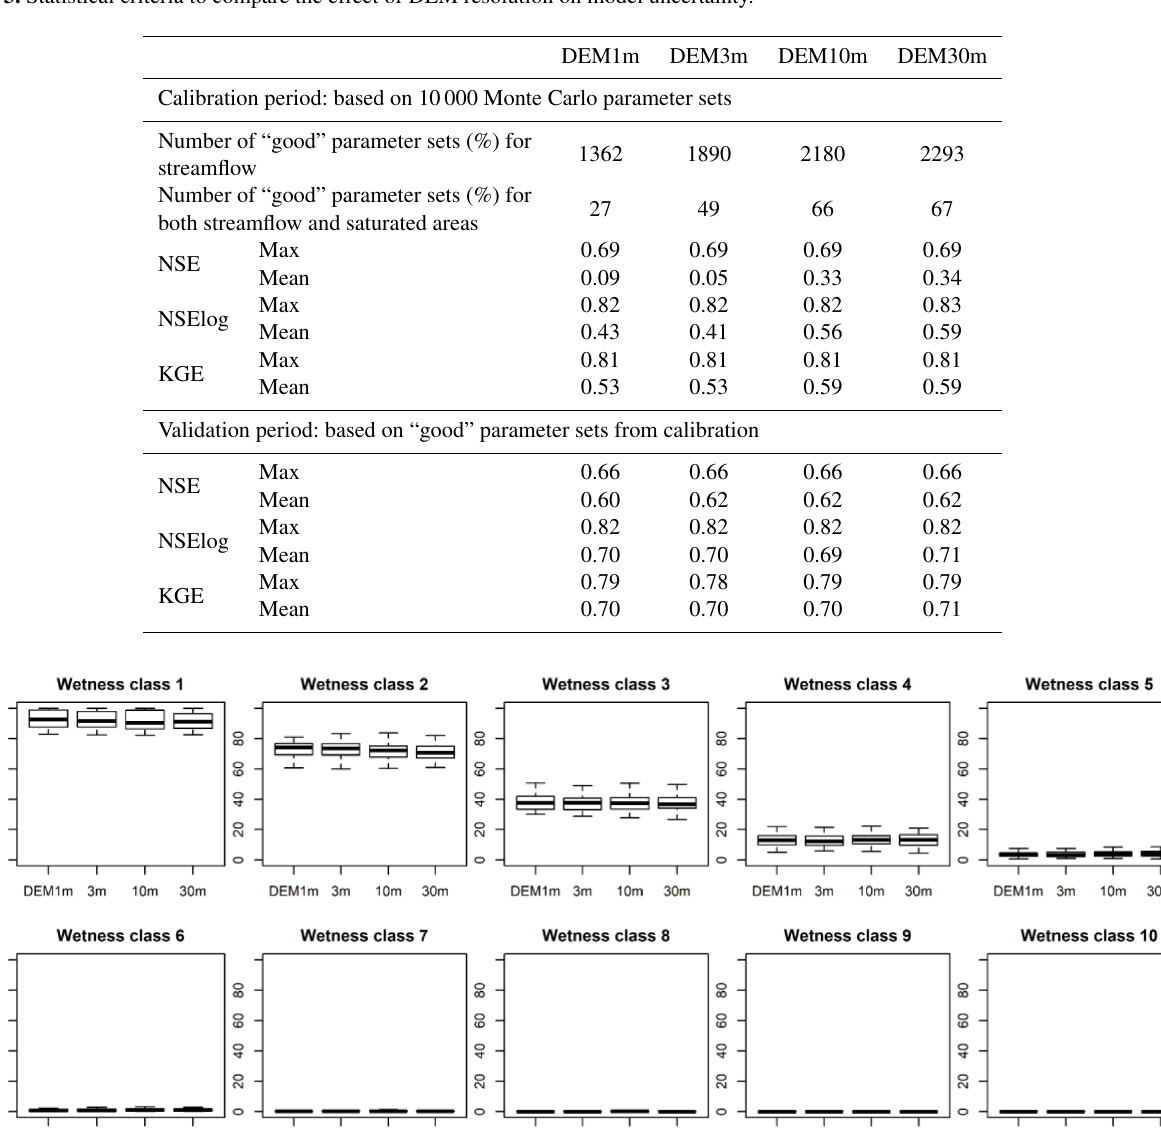
Table 3. Statistical criteria to compare the effect of DEM resolution on model uncertainty.